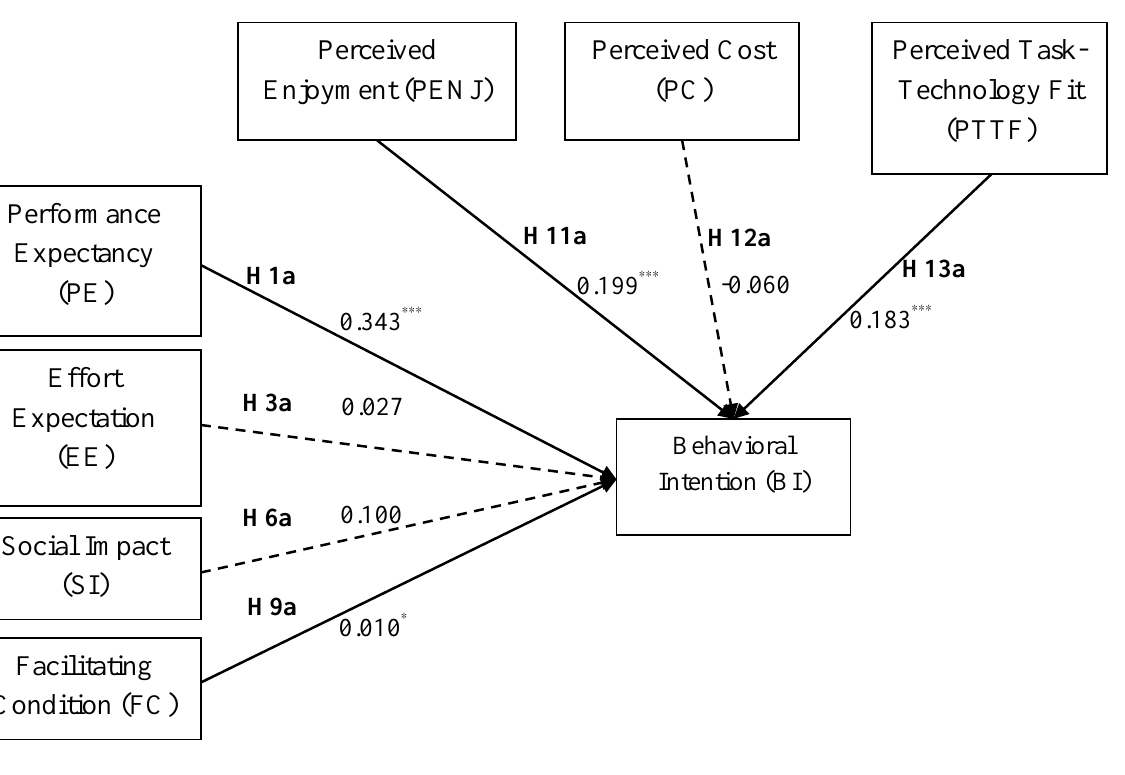
Figure 2. Path analysis of experienced